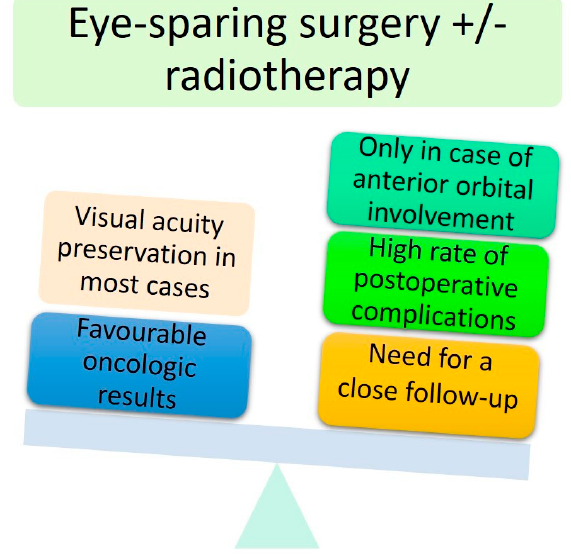
Figure 6. Main advantages and disadvantages of conservative surgery.